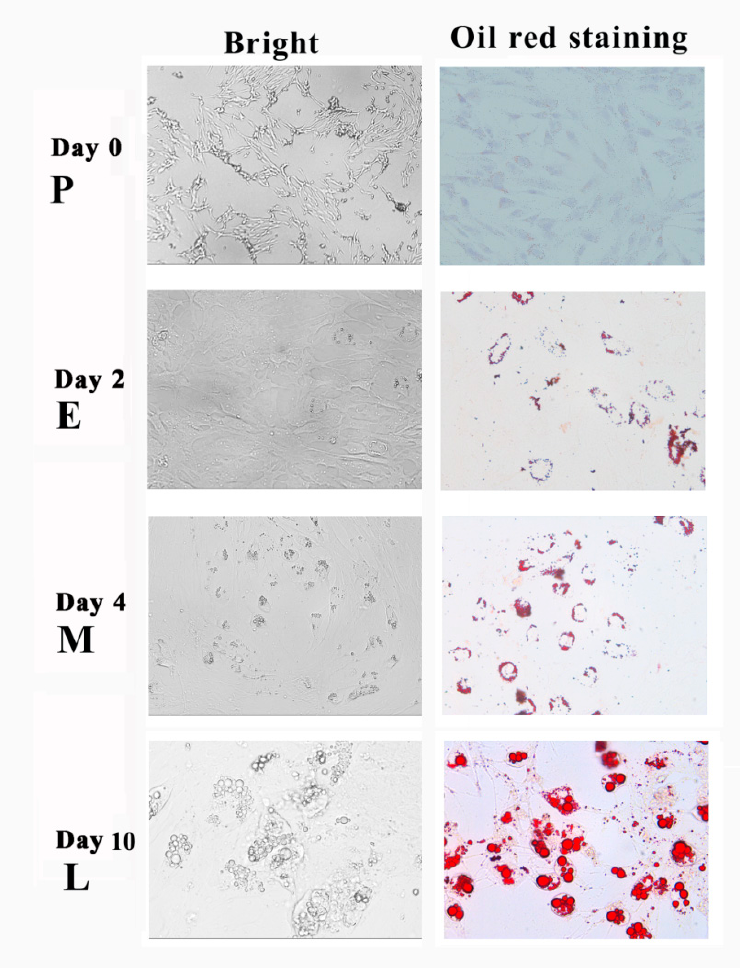
Figure 1. Adipogenic trans-differentiated porcine skeletal muscle satellite cells at pre-, early-, middle- and late-stages of differentiation. The cells are stained with Oil red O during the adipogenesis process.